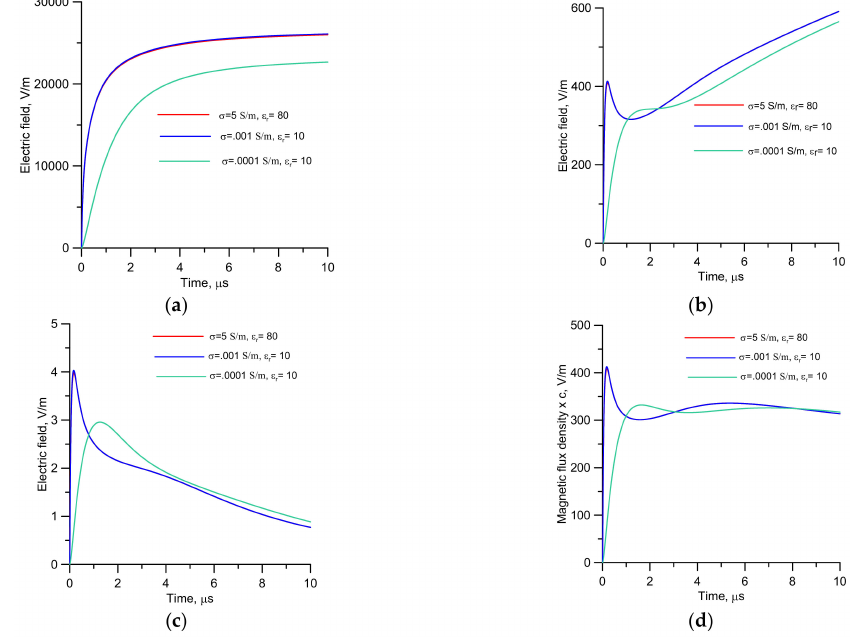
Figure 12. The source electric and magnetic fields generated by a subsequent return stroke for three sets of electric parameters at the strike point when including the current reflection at ground